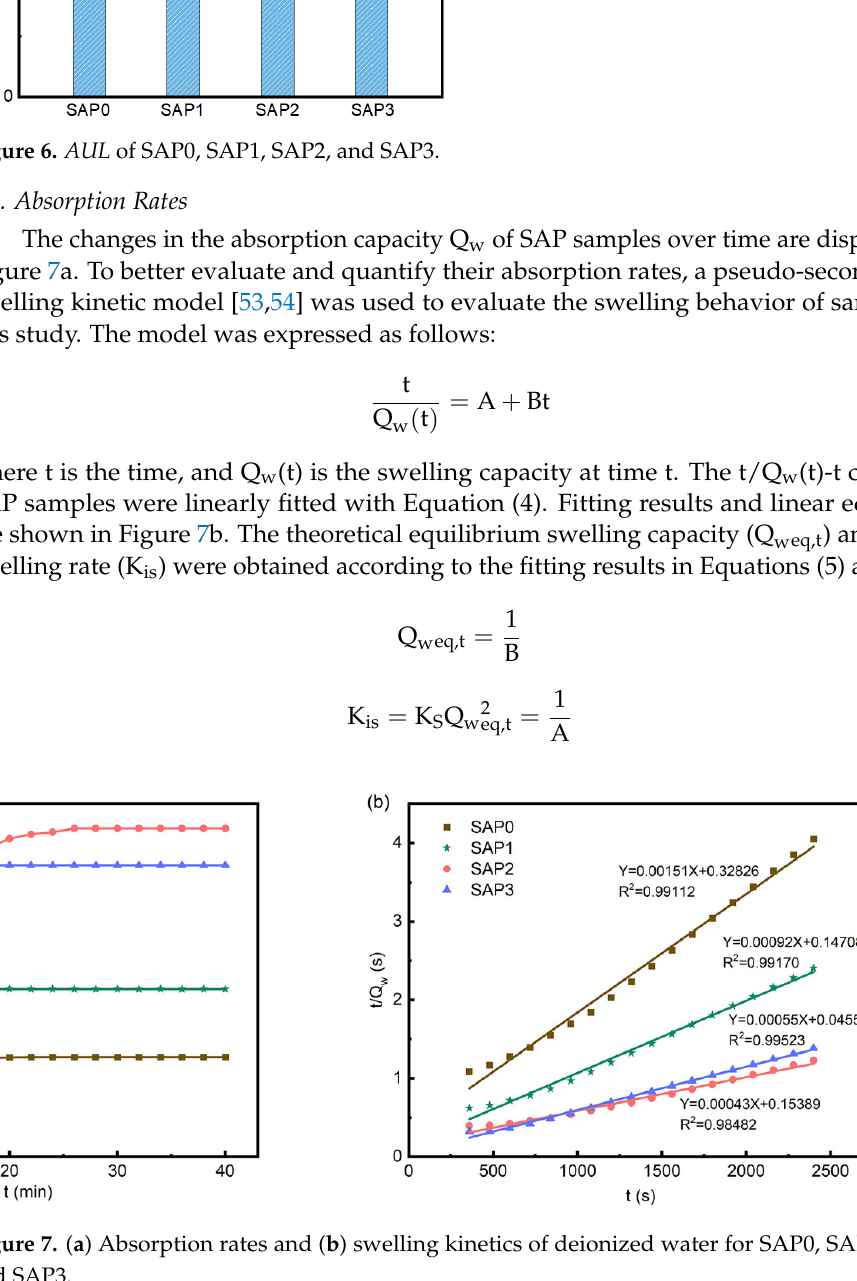
Figure 7. ( a ) Absorption rates and ( b ) swelling kinetics of deionized water for SAP0, SAP1, SAP2, and